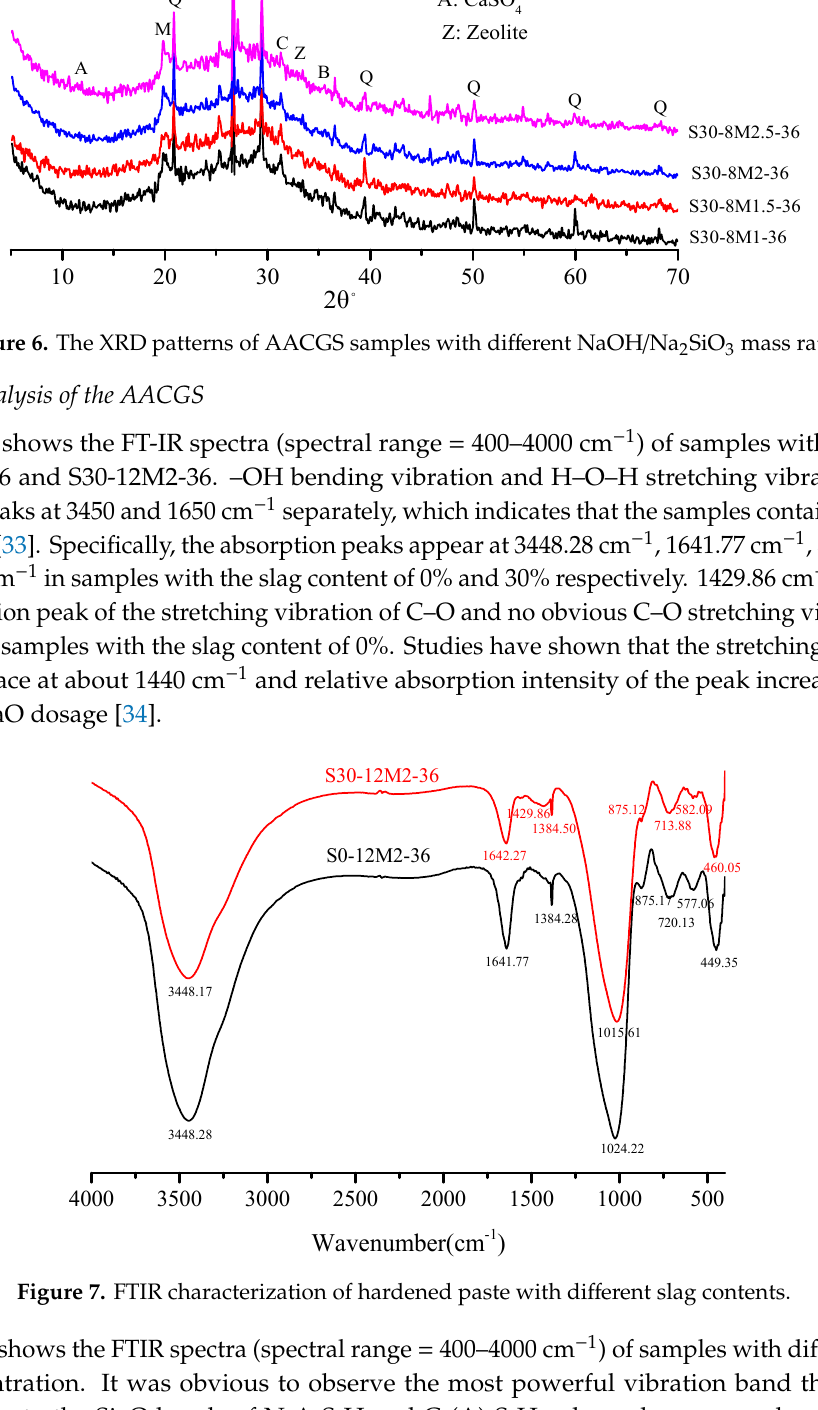
Figure 5. The XRD patterns of AACGS samples with different slag content.